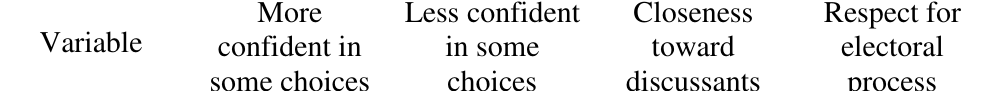
Effect of discussion elements on confidence in voting choices, closeness toward political discussants, and respect for electoral process, controlling for demographic and political background